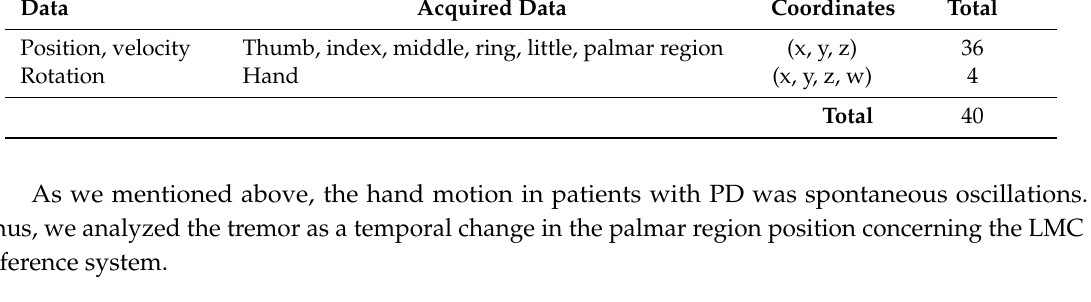
Table 2. Hand measurement captured with the leap motion controller (LMC). Data Acquired Data Coordinates Total Position, velocity Thumb, index, middle, ring, little, palmar region 36 Rotation